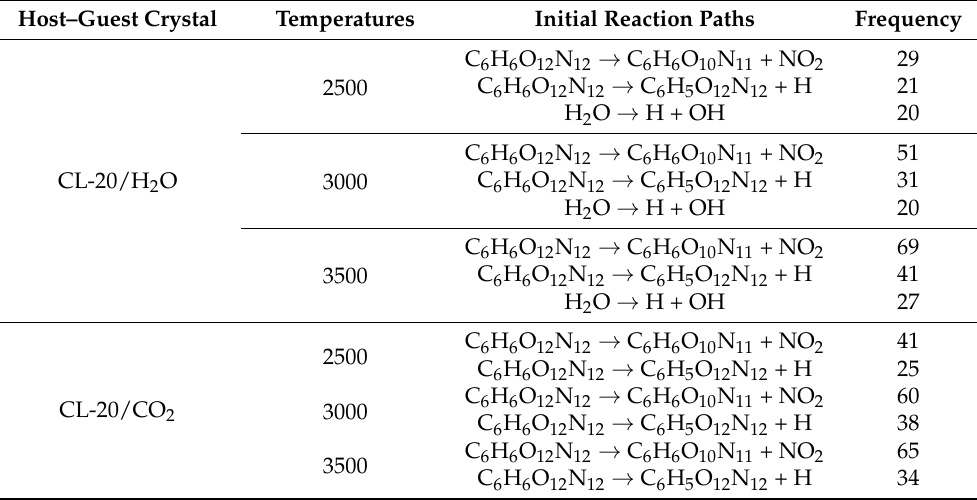
Table 1. The initial reaction paths of host–guest molecules and their occurrence frequency for CL-20/H 2 O, CL-20/CO 2 , CL-20/N 2 O, CL-20/NH 2 OH at four high